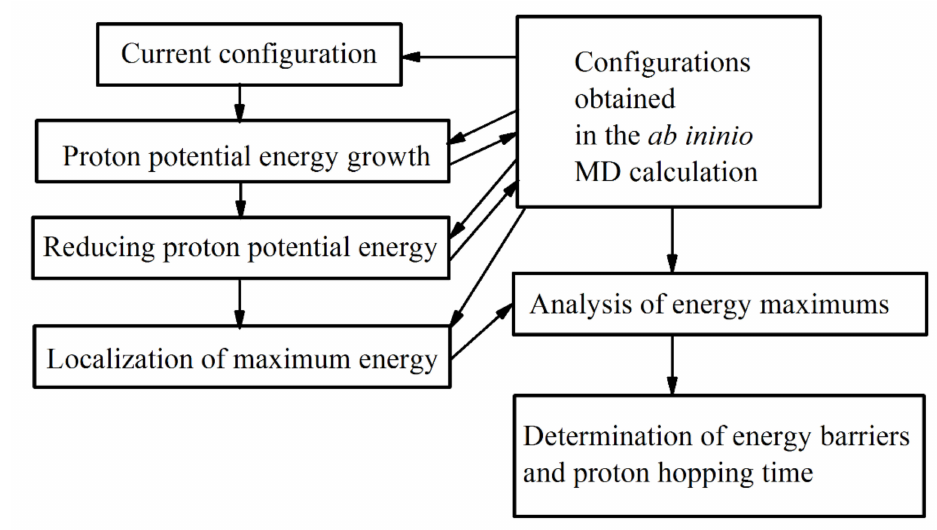
Figure 3. The block diagram of searching for proton